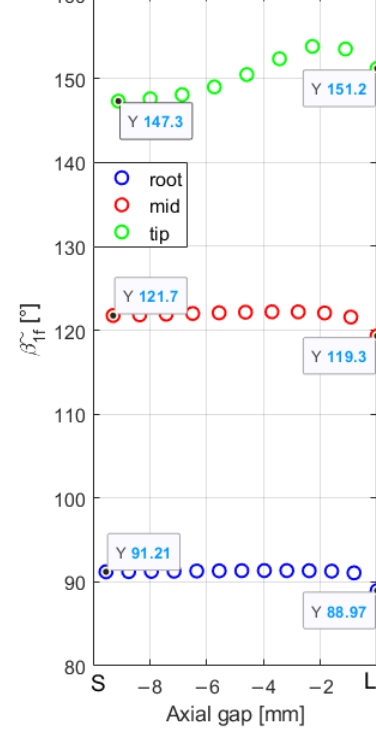
Figure 12. Mass-averaged relative velocity angles to the bucket in the axial gap: ( a ) v1; ( b ) v2; ( c ) v3; and ( d ) v4.